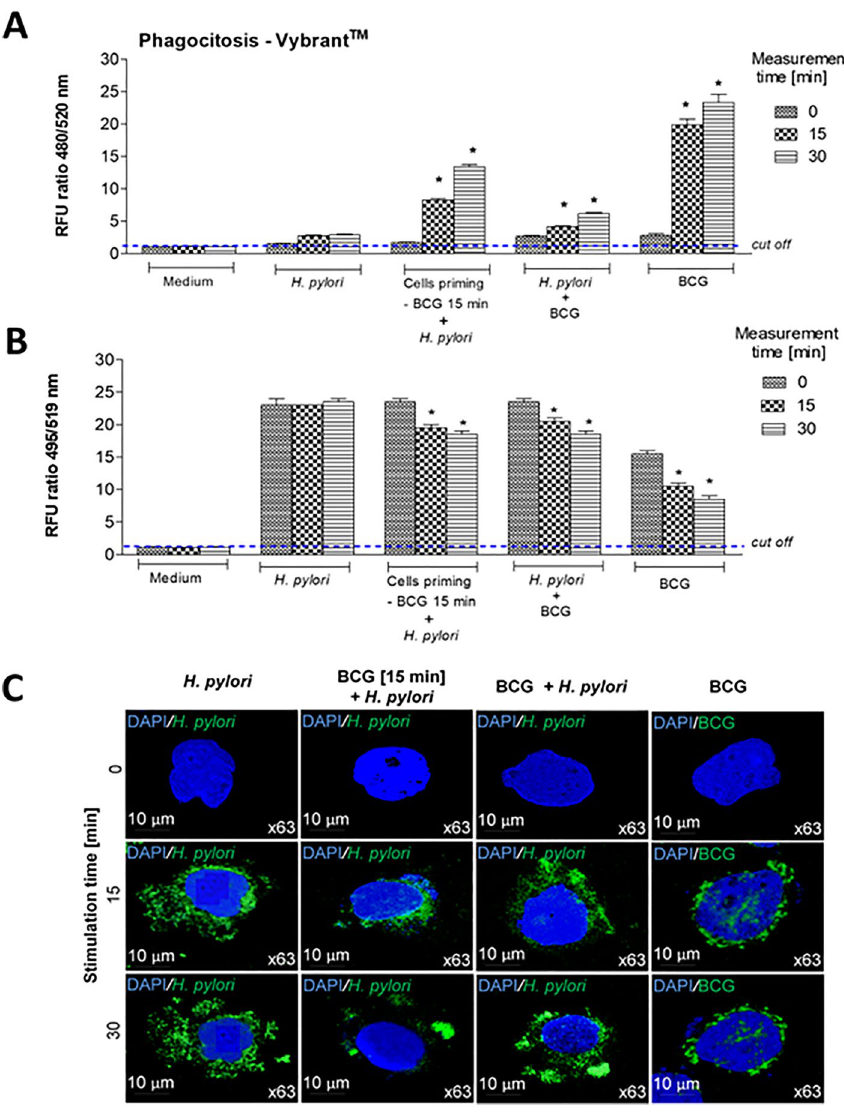
Figure 1. The influence of short exposure of THP-1 monocytes to M. bovis BCG on their phagocytic properties towards fluorescently labeled E. coli particles or H. pylori . The ingestion by THP-1 cells of fluorescently labeled E. coli (Vybrant phagocytosis assay kit) ( A ) was assessed in time 0 and after 15 min and 30 min using the following variants of cell cultures: cells exposed to H. pylori alone, cells exposed to BCG (15 min) and then to H. pylori , cells exposed simultaneously to BCG and H. pylori , or cells exposed to BCG alone or cells in RPMI-1640 medium alone (control). The fluorescence of intracellular bacteria was measured. The phagocytic capacity of THP-1 cells towards fluorescently labeled H. pylori ( B ) was assessed in time 0 and after 15 min and 30 min using the following variants of cell cultures: cells exposed to fluorescently labeled H. pylori alone, cells exposed to unlabeled BCG (15 min) and then to fluorescently labeled H. pylori , cells exposed simultaneously to unlabeled BCG and fluorescently labeled H. pylori , or cells exposed to fluorescently labeled BCG alone. The intensity of fluorescently labeled bacteria remaining in the supernatants was measured. Results ( A , B ) are presented as ratio of median fluorescence units (RFU) ± range of three independent experiments. The difference statistically significant when p < 0.05 in Mann–Whitney U test. *Cells stimulated versus unstimulated (according to the time of stimulation). Images of THP-1 cells exposed to fluorescently labeled H. pylori or M. bovis BCG alone, to unlabeled M. bovis BCG and then to fluorescently labeled H. pylori , or simultaneously to unlabeled M. bovis BCG and fluorescently labeled H. pylori , in the fluorescence microscope ( C ). BCG or H. pylori MOI